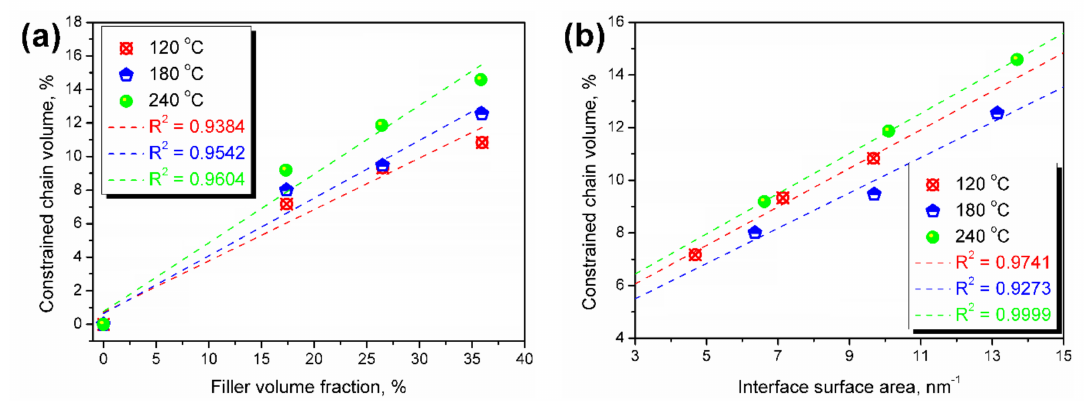
Figure 11. Constrained chain volume of prepared composites as a function of ( a ) filler volume fraction, and ( b ) interface surface